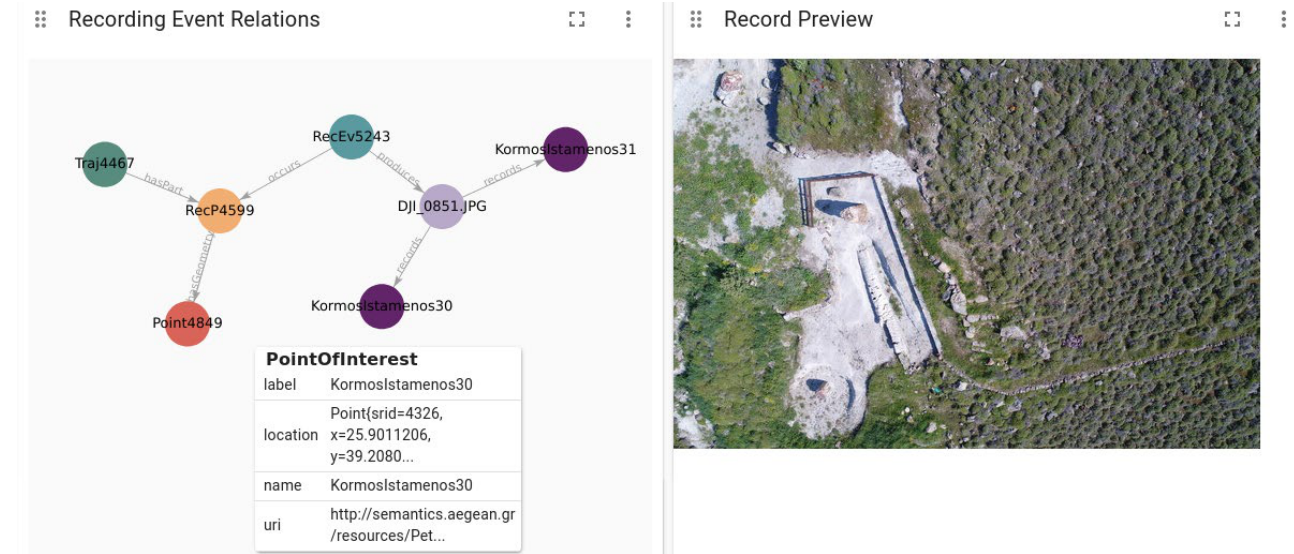
Figure 14. Visualization of information regarding a recording event and record preview. Recording segments of a trajectory (Figure 15) are visualized through a map report that displays the results of a Cypher query (Appendix B.4) for a selected trajectory.